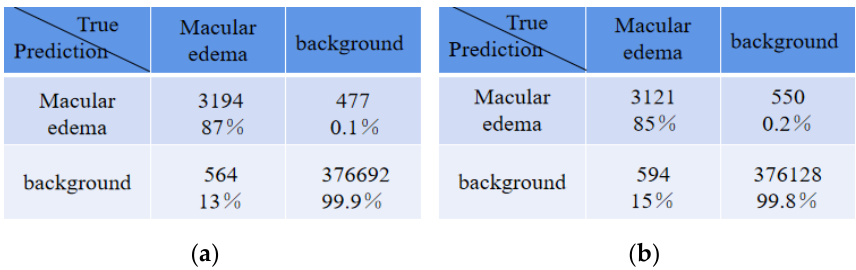
Table 3. Quantitative comparison of segmentation results around fovea edema regions. Figure 11. Quantitative comparison of confusion matrices: ( a ) the proposed method; ( b ) ReLayNet.